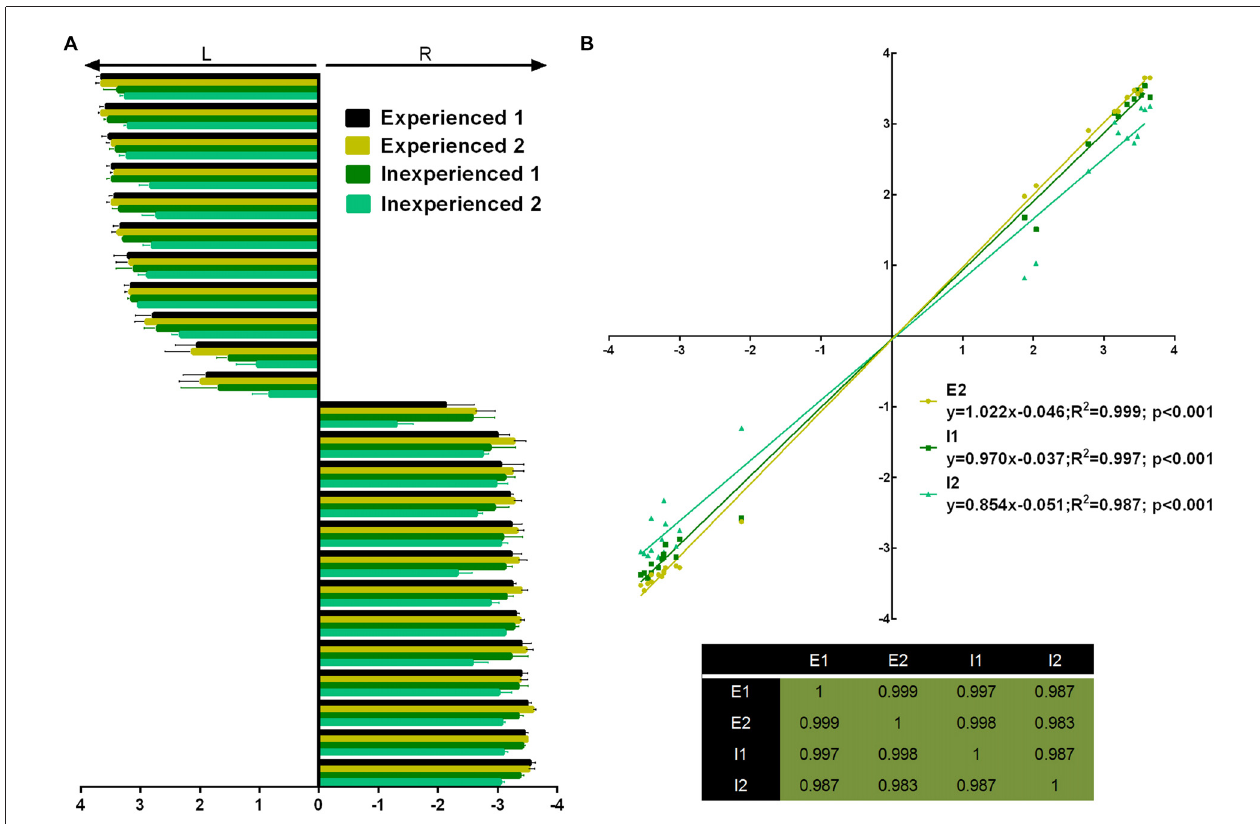
FIGURE 2 | Pawdeness trait test (PaTRaT) rater comparison. Two experienced and two inexperienced raters scored the first pawedness evaluation. (A) Representation of the score attributed by each rater for each animal shown as mean ± SEM. (B) Experienced rater 1’s scores correlated with scores attributed by all other raters (graph) and all raters show high correlation between them (table of R 2 s). L, Left; R, Right; E, experienced; I,